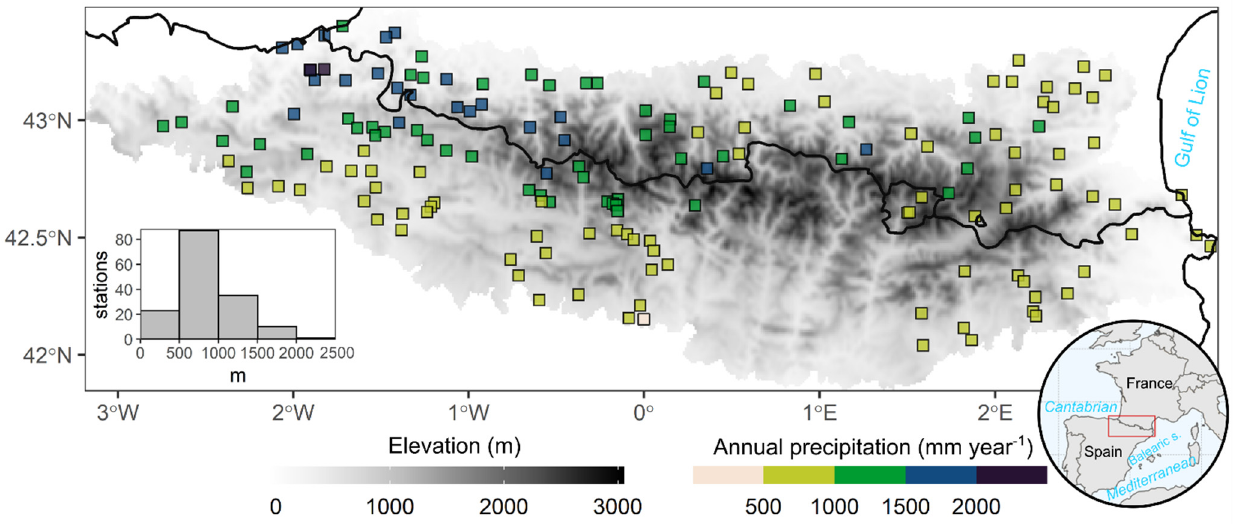
Figure 1. Pyrenees location ( bottom right ), elevation ( greyscale legend ) and spatial distribution of the rain gauges in the Pyrenees area and annual amounts of precipitation ( coloured squares ). At bottom left, a histogram shows the frequency of rain gauges per range of elevation. The black line shows the national boundaries.